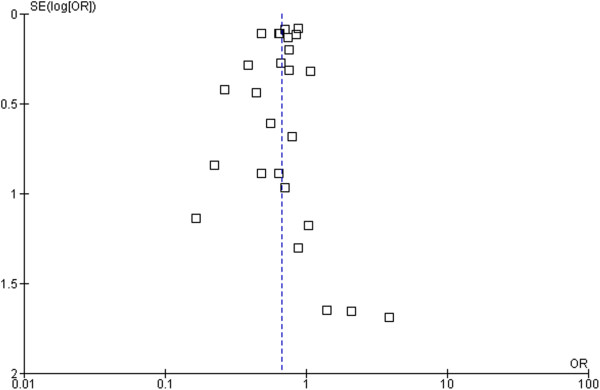
Funnel plot of SE (log odds ratio) by odds ratio to evaluate publication bias for effect of treatment for all-cause mortality.